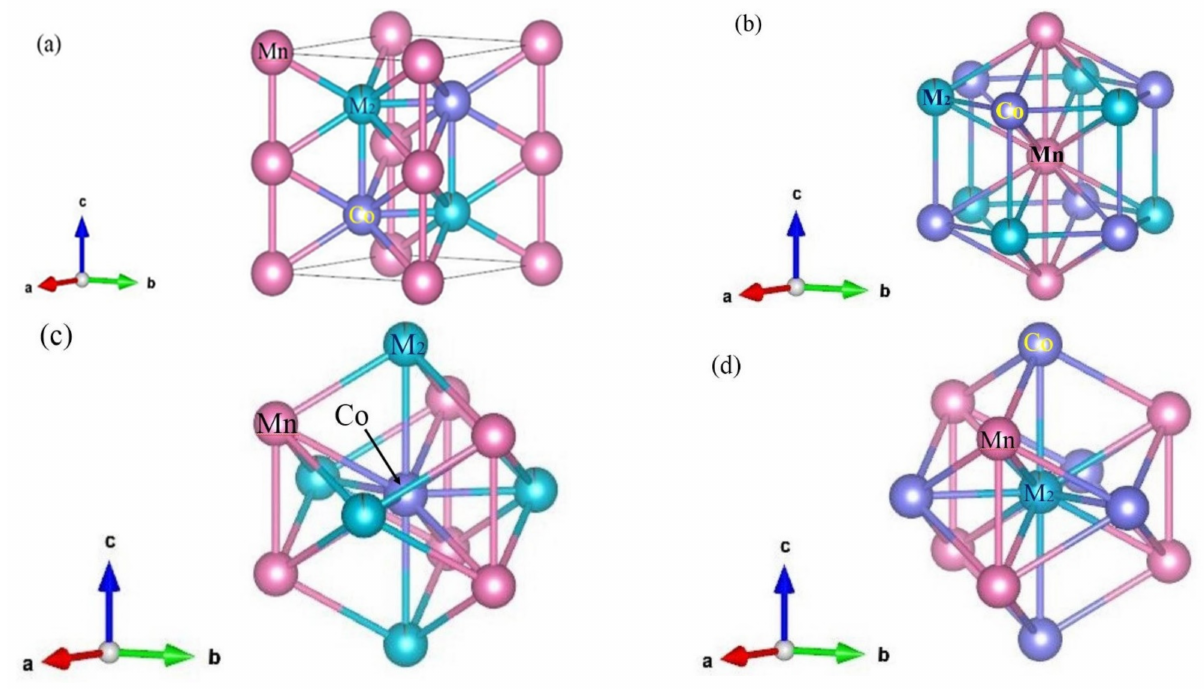
Figure 4. MnCoGe 0.97 La 0.03 crystal structure: ( a ) the crystal structure of the MnCoGe 0.97 La 0.03 ; ( b ) the atomic environments of Mn; ( c ) Co and ( d ) M 2